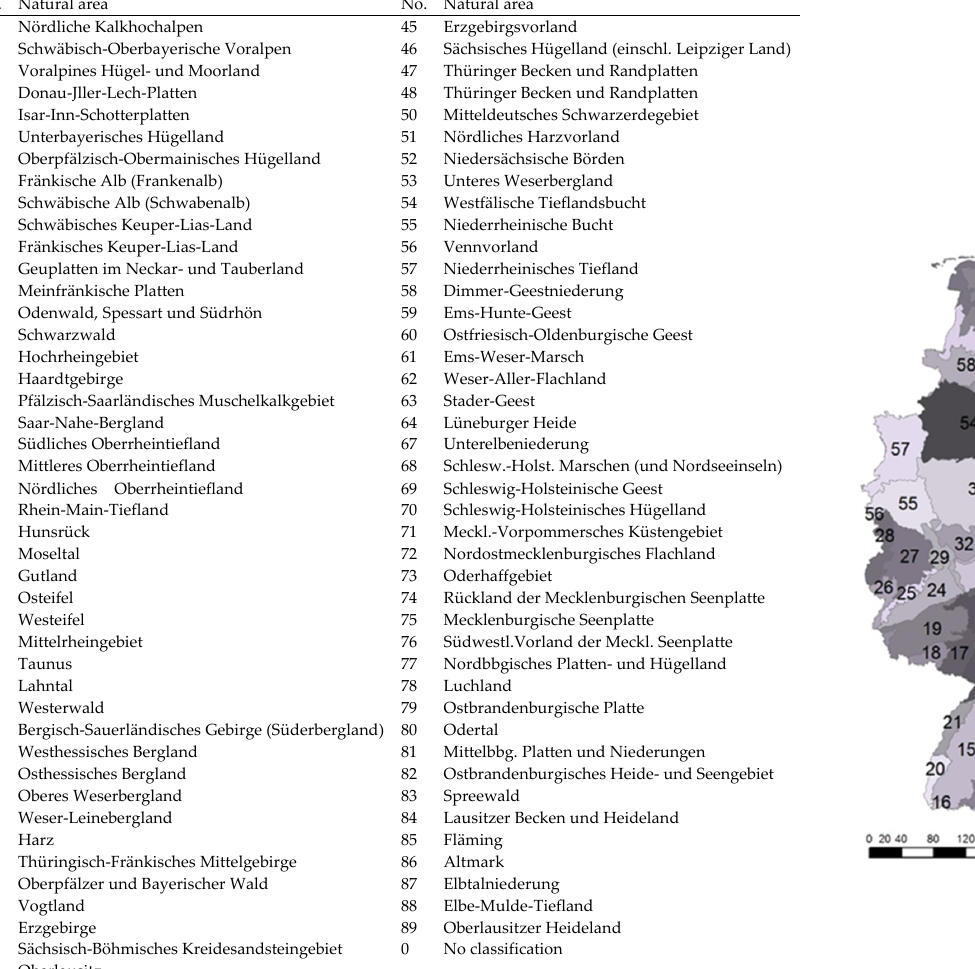
Figure A2. German natural regions after